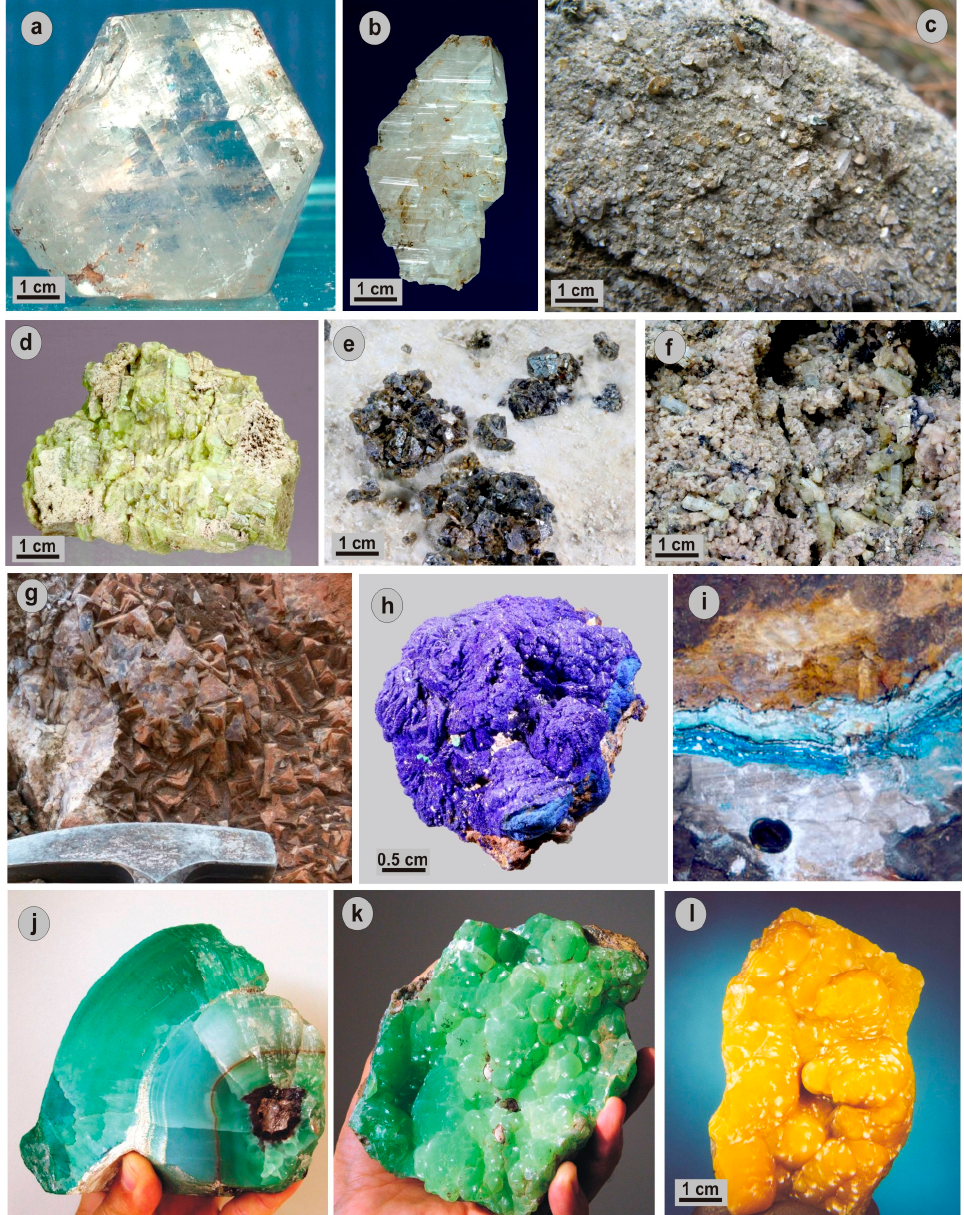
Figure 12. Field and hand specimens photographs demonstrating occurrences/crystals of various gemstones from Greece: ( a , b ) albite from Krieza, Evia Island; ( c ) titanite and quartz from Trikorfo, Thassos Island; ( d ) vesuvianite from the Maronia skarn; ( e ) spinel in marble from Gorgona, Xanthi; ( f ) apatite and K-feldspar from potassically-altered monzonite, Fakos, Limnos Island; ( g ) purple fluorite coated with iron oxides, Ampelos, Samos Island; ( h ) azurite, Kamariza, Lavrion deposit; ( i ) blue smithsonite within marble at the interface with Fe-oxides, Kamariza, Lavrion; ( j – l ) colored varieties of smithsonite, Kamariza, Lavrion deposit; Photographs 12b,d,e,f,h are courtesy of Berthold Ottens.